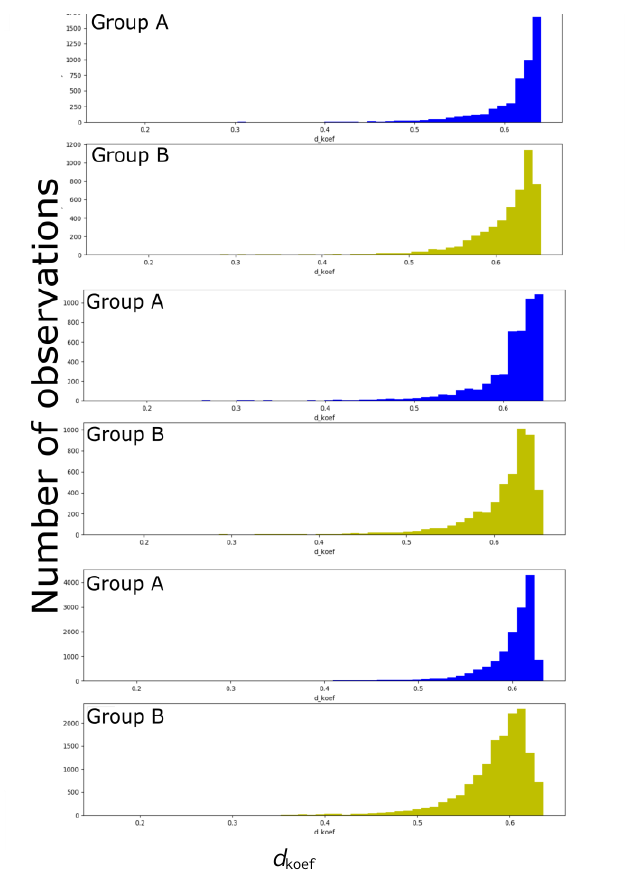
Fig. 5. Histograms of middle branch splitting length. Blue for Group A histogram, yellow for Group B. acceleration graph in Fig. 7); abnormal behaviour occurs at a steady speed n; most often acceleration occurs.